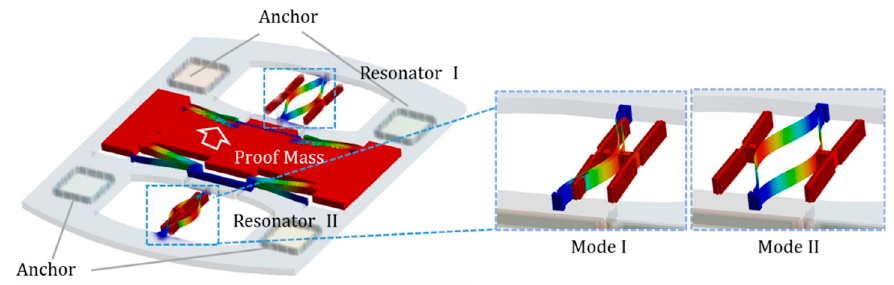
Figure 2. Operating principle of resonant accelerometer with two resonators.